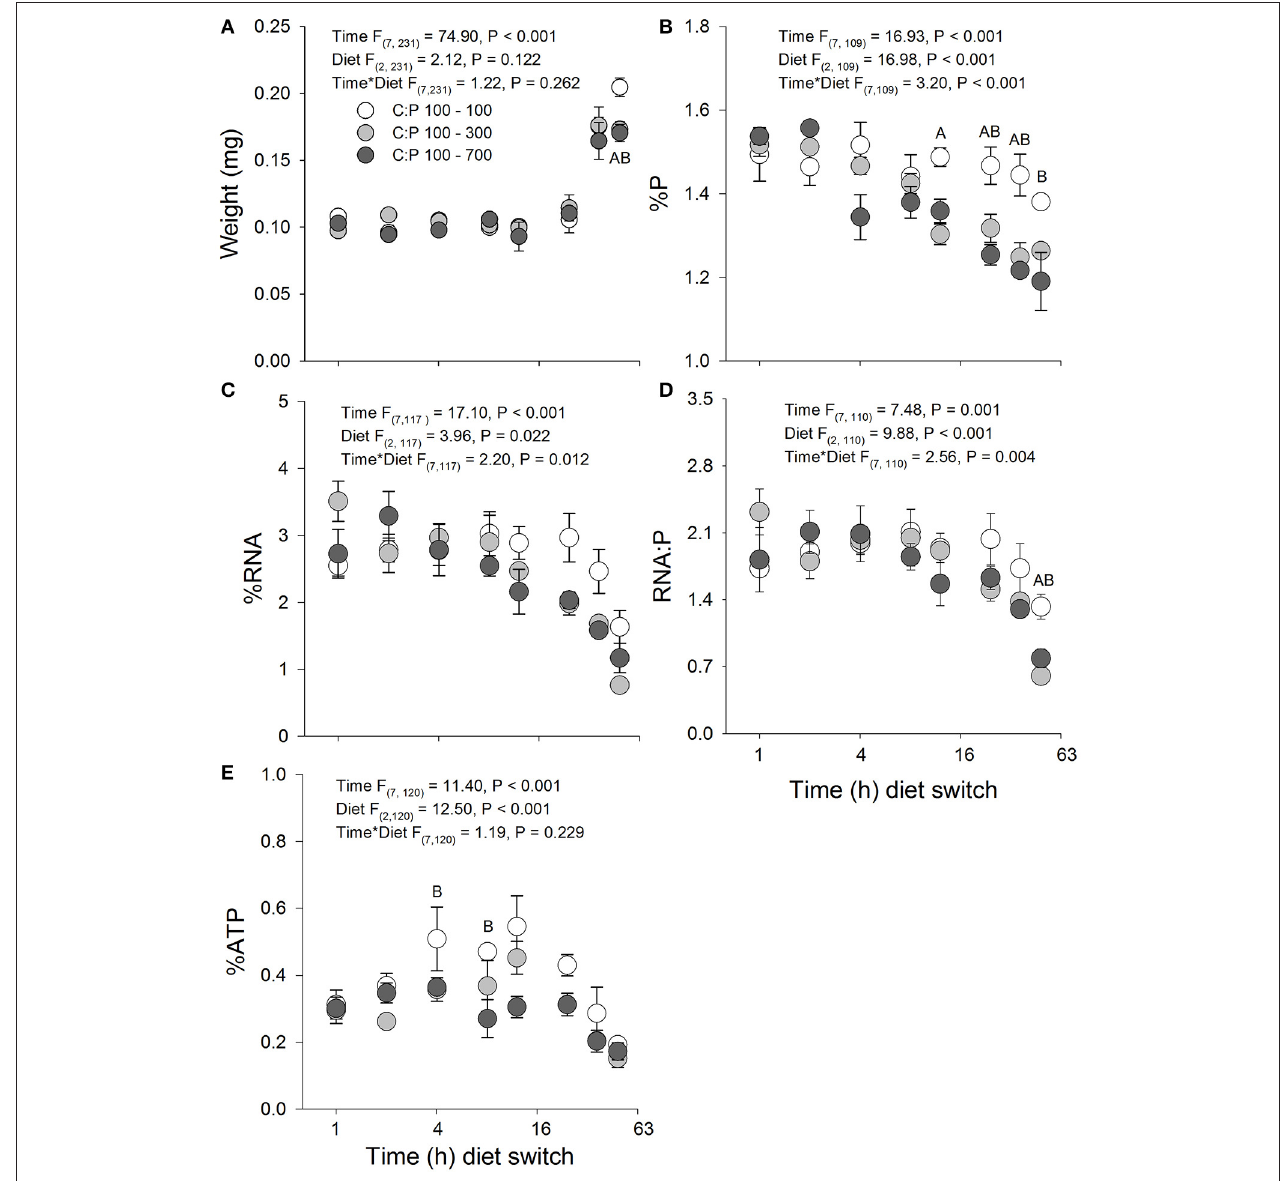
FIGURE 2 | Acute averages ± standard error in Daphnia mass (A) and metabolic P-pools ( B ; body %P, C ; body %RNA, D ; RNA:P, E ; body %ATP). White circles are animals maintained at C:P 100 while light gray, and dark gray circles represent animals that were switched to C:P 300, and C:P 700, respectively. Post-hoc significant differences between C:P 100–300 represented with (A) and CP:100–700 represented with a (B) ( P <